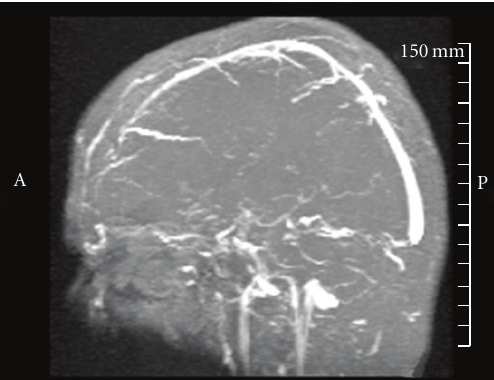
Figure 4: MRV on